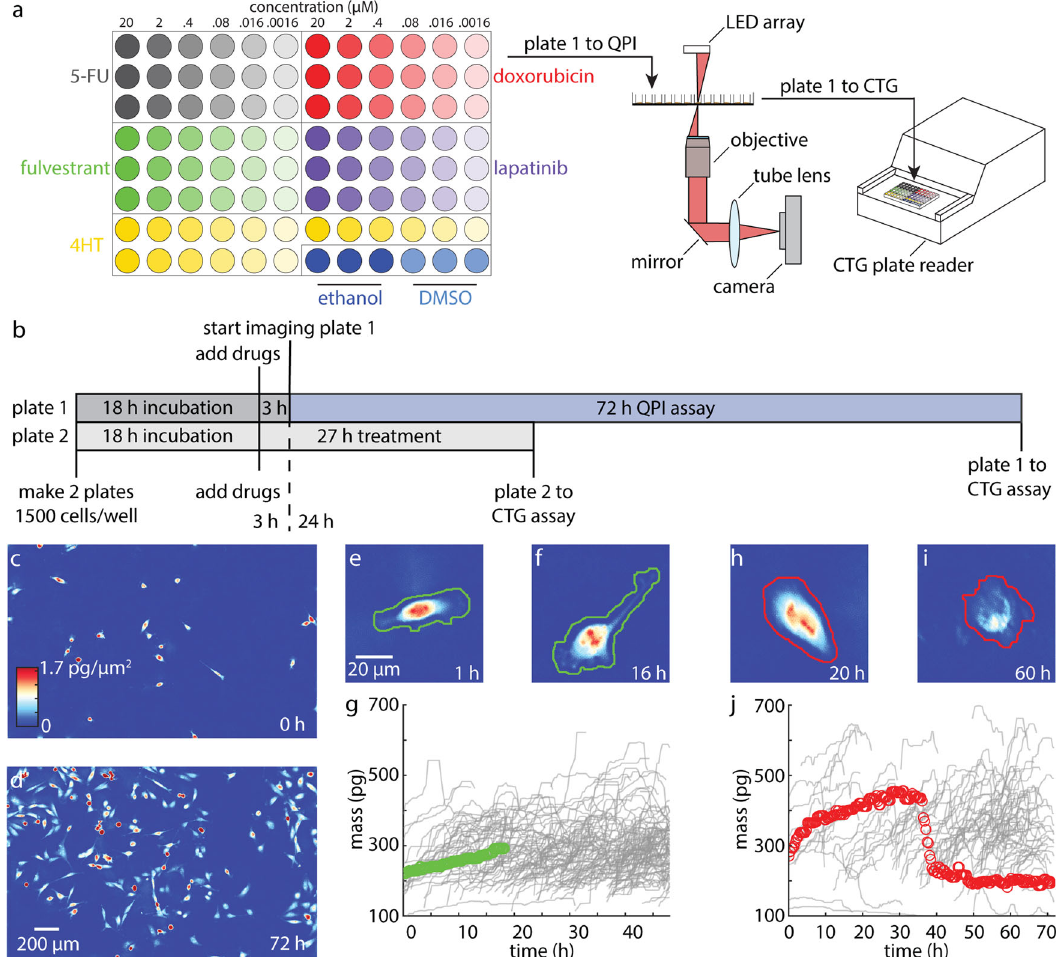
Fig. 1 QPI measures drug sensitivity and temporal dynamics for more than 20,000 cells in a single experiment. a Example plate setup for measuring a 6-point dose response of fi ve cancer therapies in triplicate in addition to two solvent controls (left). Growth response of cells are fi rst measured non- invasively using QPI (center) before being assayed using CTG (right). b Experimental timeline showing two plates set up in parallel to measure cell viability using CTG at 27 h after drug exposure (3 h of microscope setup plus 24 h of imaging) and 75 h after drug exposure (3 h of microscope setup plus 72 h of imaging) c Representative QPI data from a single location within a single DMSO control well at 0 h, d and at 72 h with 10 – 100 MDA-MB-231 cells imaged per location. Scalebar is 200 µ m. e – f QPI image of a growing cell in DMSO (solvent control) at 1 h and at 16 h. Automatically segmented boundary for healthy growing cell is shown in green. g Corresponding measurement of growing cell mass versus time (green) and other cells from the same well (gray). h – i QPI image of a dying cell in 2 μ M doxorubicin shown at 20 h while still growing and at 60 h, after the cell death event has occurred. Automatically segmented boundary for dying cell shown in red. j Corresponding mass versus time for dying cell (red) and other cells from the same